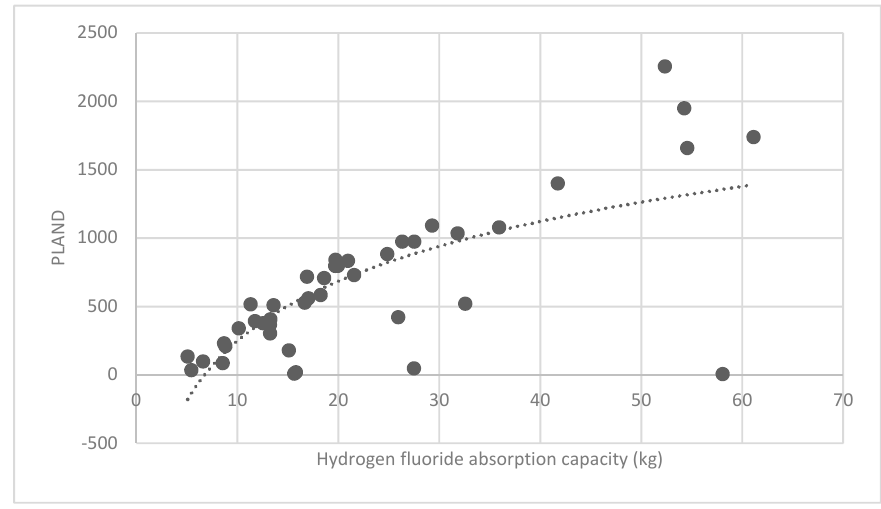
Figure 16. Association between forest land PLAND index and hydrogen-fluoride absorption capacity.